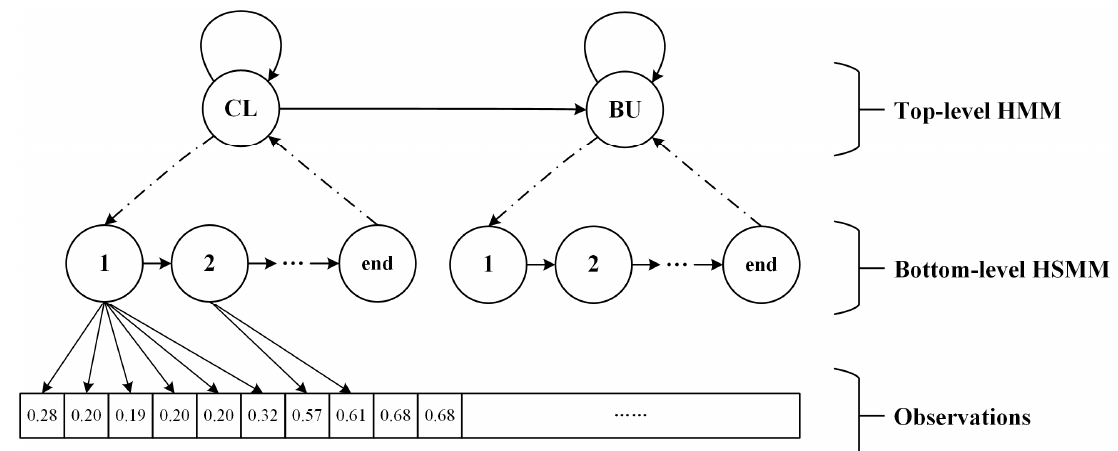
Figure 8. Model topology of the proposed two-level hierarchical hidden semi-Markov model. A state in the top-level HMM corresponds to a certain land-cover type (CL: cultivated land; BU: built-up land), and its substates in the bottom-level denote the phenological stages.